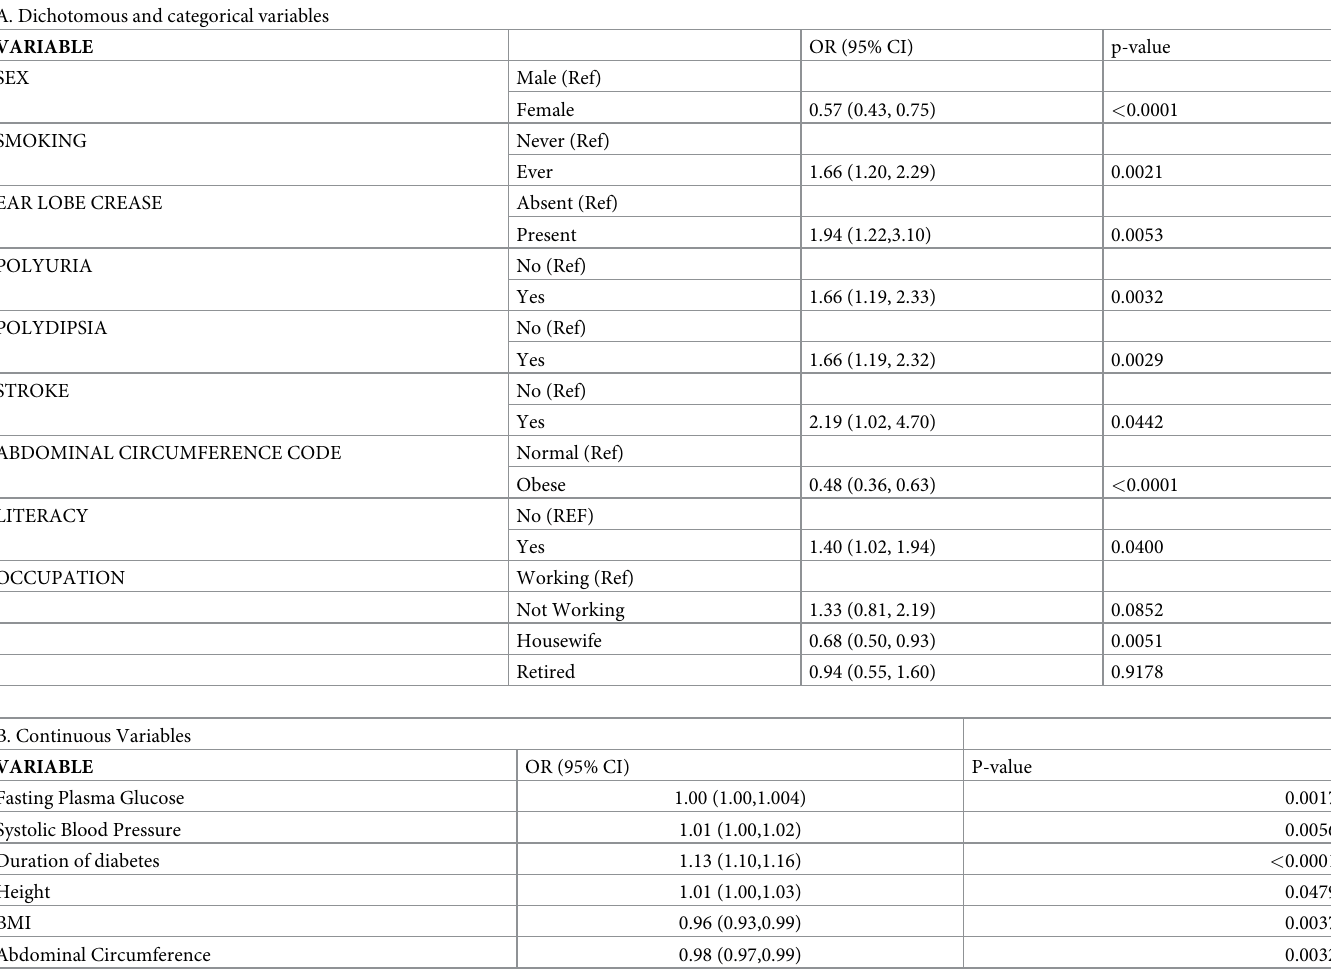
Table 2. Significant variables of DR association from univariate analyses.